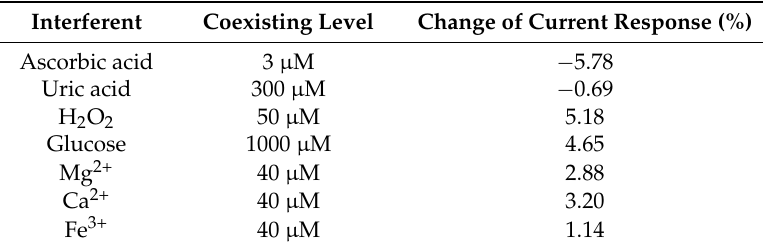
Table 1. Effect of some interference species on the sensor